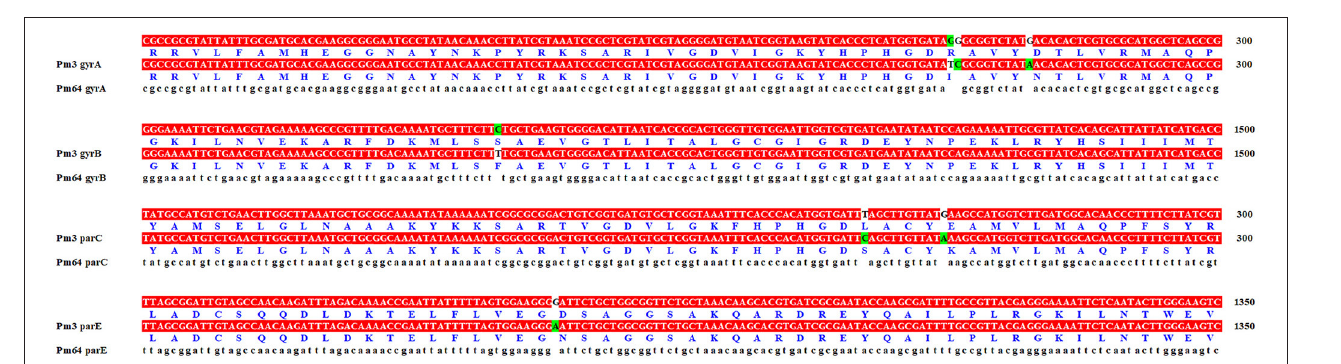
Frontiers in Veterinary Science |